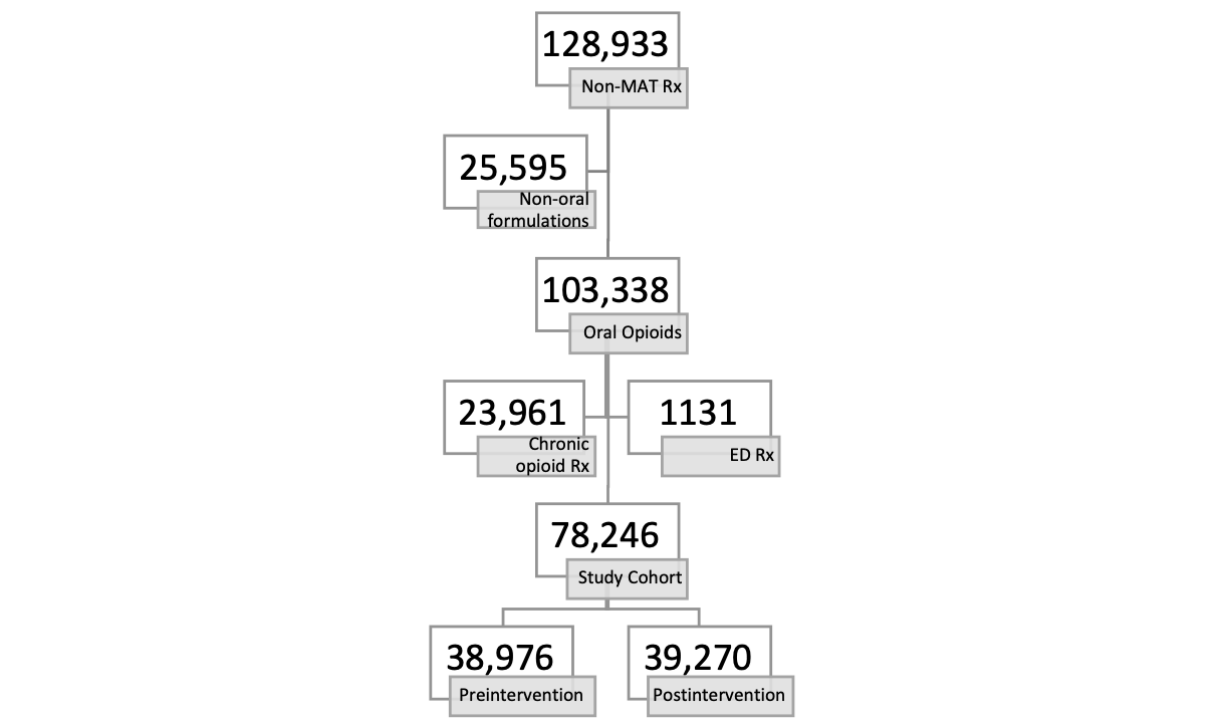
Figure 1. Breakdown of our study cohort included excluded groups. ED: emergency department; MAT: medical assisted treatment.